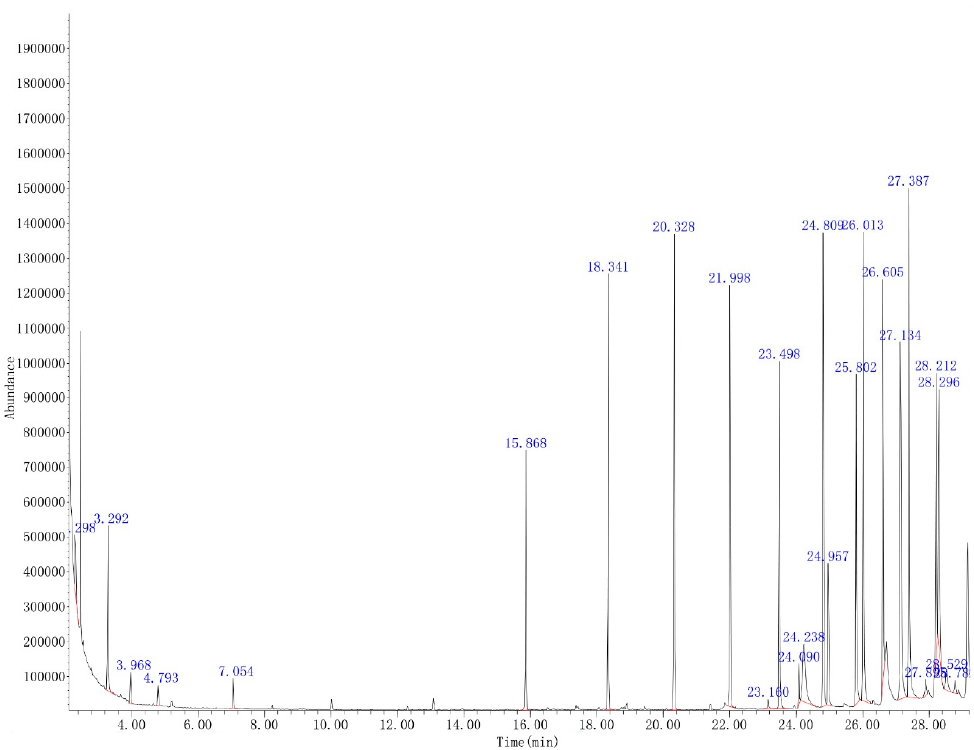
Figure 4. TIC of unregulated emissions absorbed by absorption liquid in conventional diesel Figure4. combustion. Table 4. Exhaust components absorbed by absorption liquid in conventional diesel combustion.